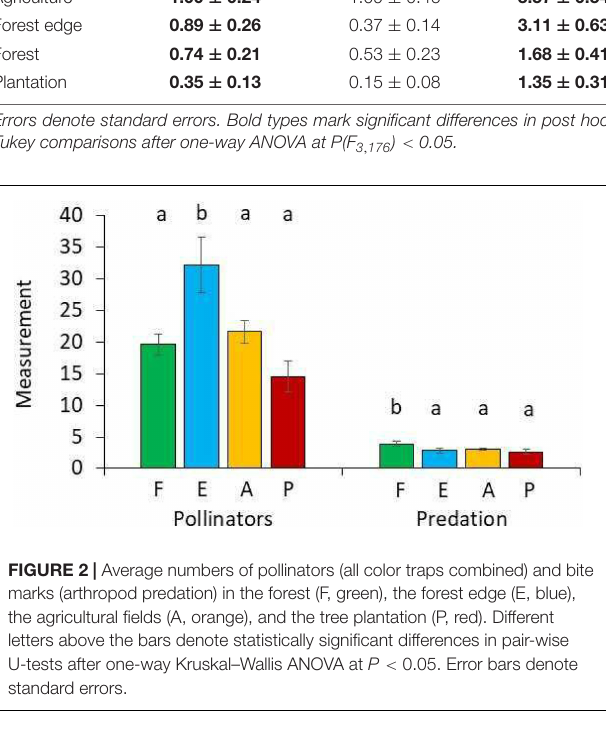
Hymenoptera, Coleoptera, and Diptera abundances were lowest in the plantations and highest in the agricultural land ( Table 1 ).